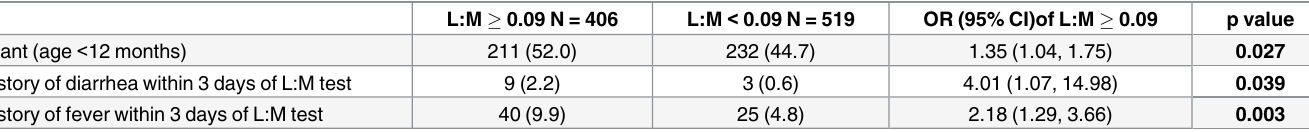
Table 4. Risk factors of impaired intestinal mucosal -integrity and -permeability (L:M (cid:21) 0.09) by backward logistic regression